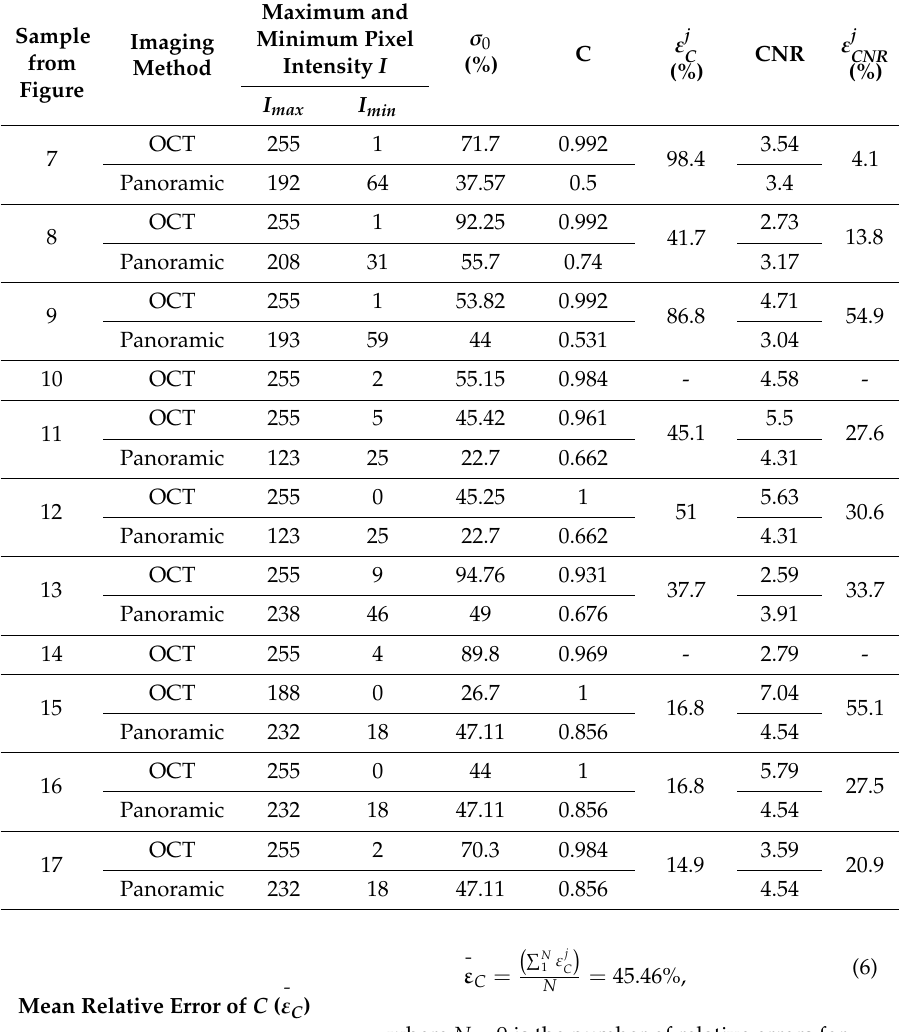
Table 2. Measurements of Contrast (C) and Contrast-to-Noise Ratio (CNR) performed on radiography and OCT images obtained for each sample considered in the